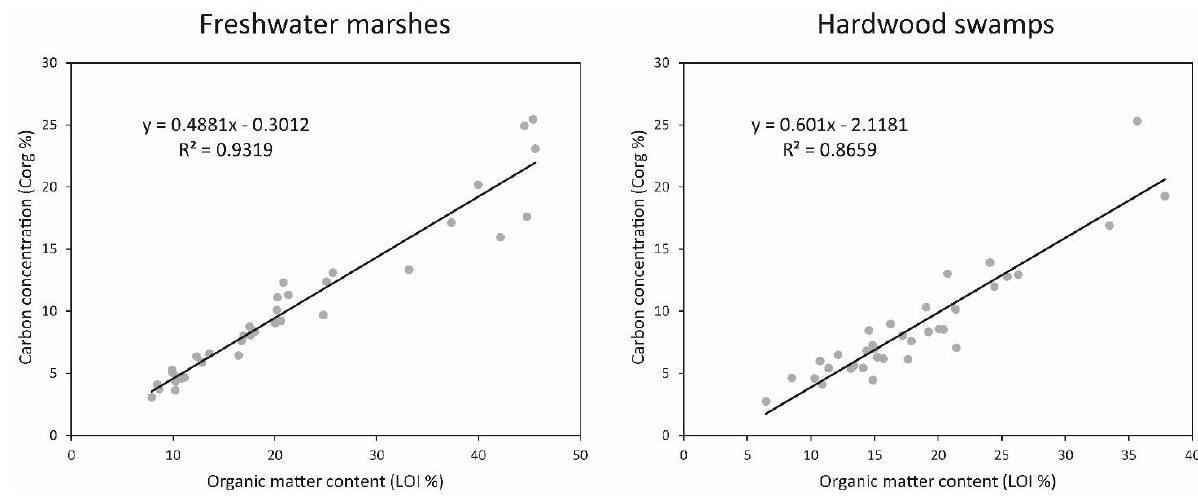
Figure 2. Relationship between organic matter content (LOI %) and organic carbon concentration (Corg %) for freshwater marshes (n=36) and hardwood swamps